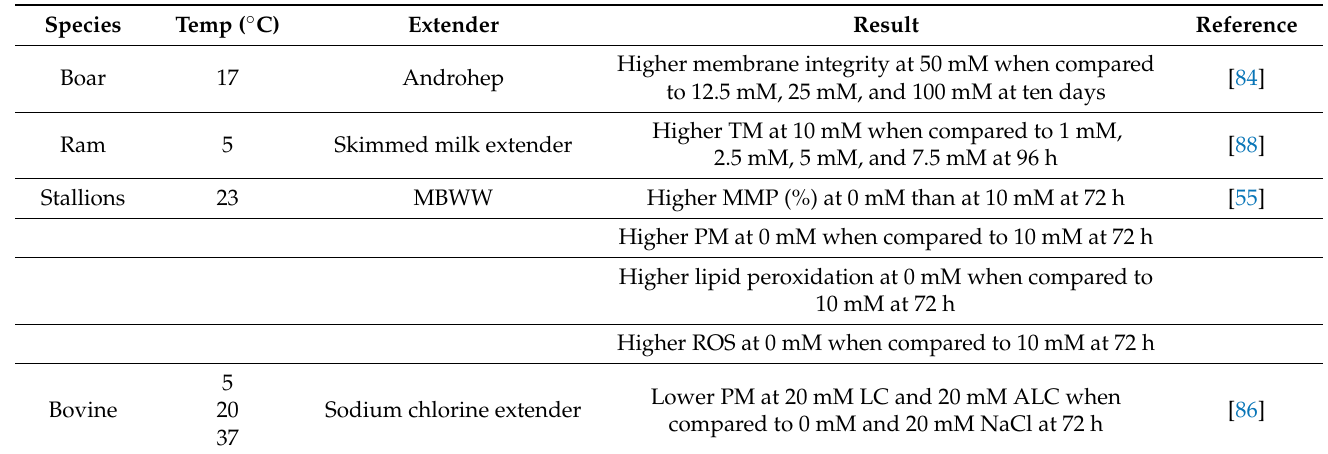
Table 4. Summary of noteworthy results on the supplementation of L-carnitine (LC) to spermatozoa during storage above 5 ◦ C in various